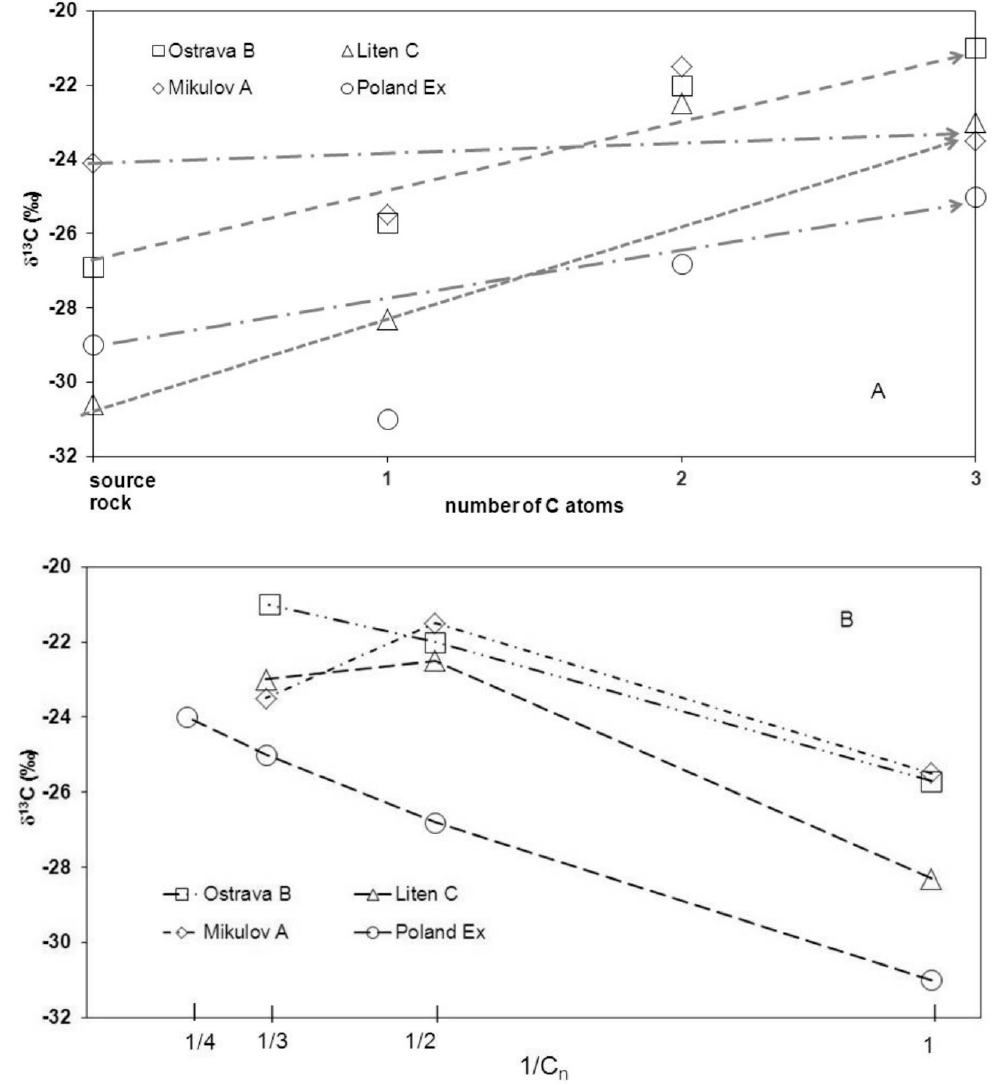
Figure 6. The relationship between δ 13 C of the source rock and the shale gas components estimated from extrapolation of 13 C fractionation to initial δ 13 C values ( A ). Diagram of 1/Cn versus δ 13 C for the same initial values according to Reference [24] ( B ).